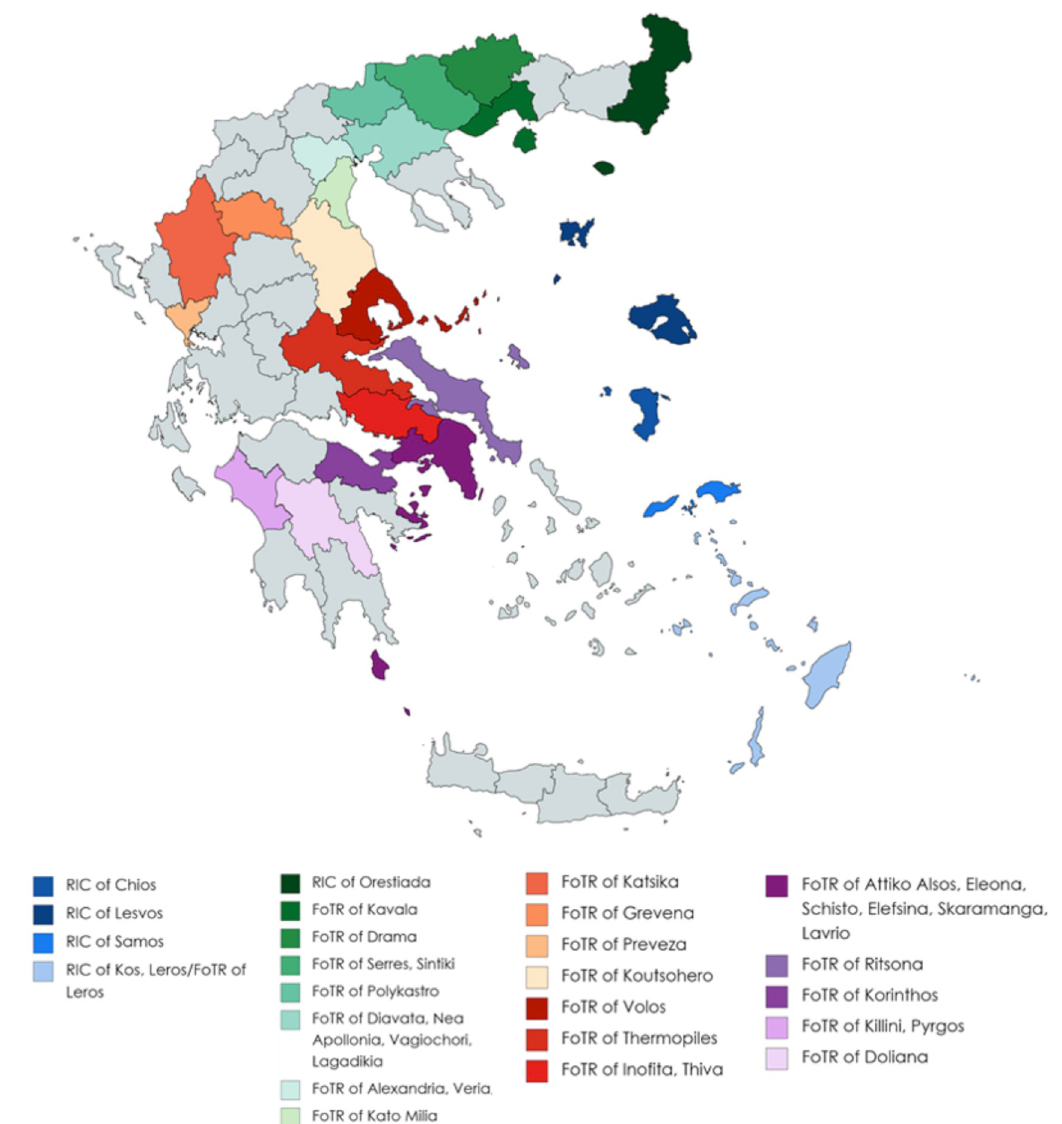
Fig 1. Geographic locations of Regional Units in Greece, as of November 2020. RIC = Reception and Identification Centers, FoTR = Facilities of Temporary Reception. Map created using MapChart (available from: https://mapchart.net/index.html)